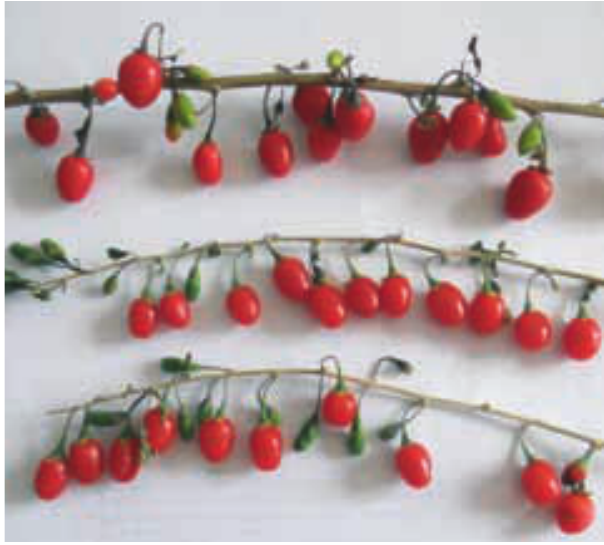
Figure 1. Comparison of Lycium fruit (berry) size,